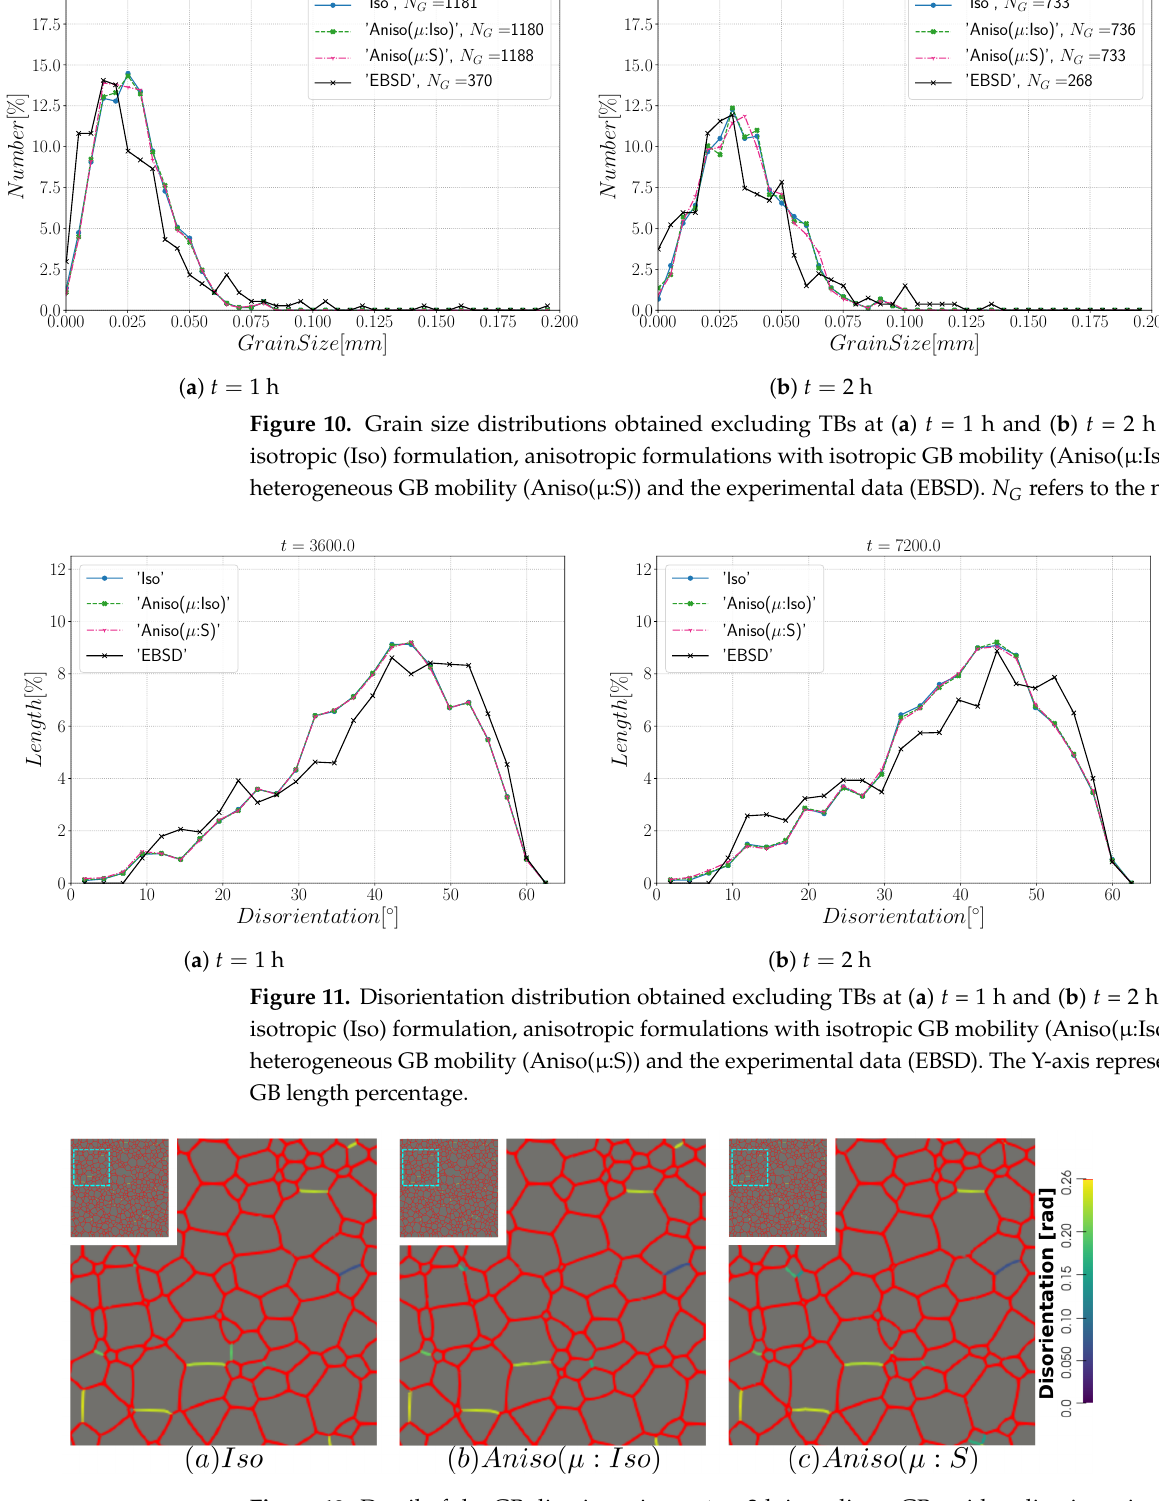
Figure 12. Detail of the GB disorientation at t = 2 h in radians, GBs with a disorientation higher than 0.26 radians (15 ◦ ) are colored in red: ( a ) isotropic framework, ( b ) anisotropic framework with γ function of θ (Equation (12)) and µ constant, and ( c ) anisotropic framework with γ and µ functions of θ through Equation (12) and Equation (13), respectively. Due to the few GBs with θ < 0.26, just a square section at the top-left of the hole microstructure is